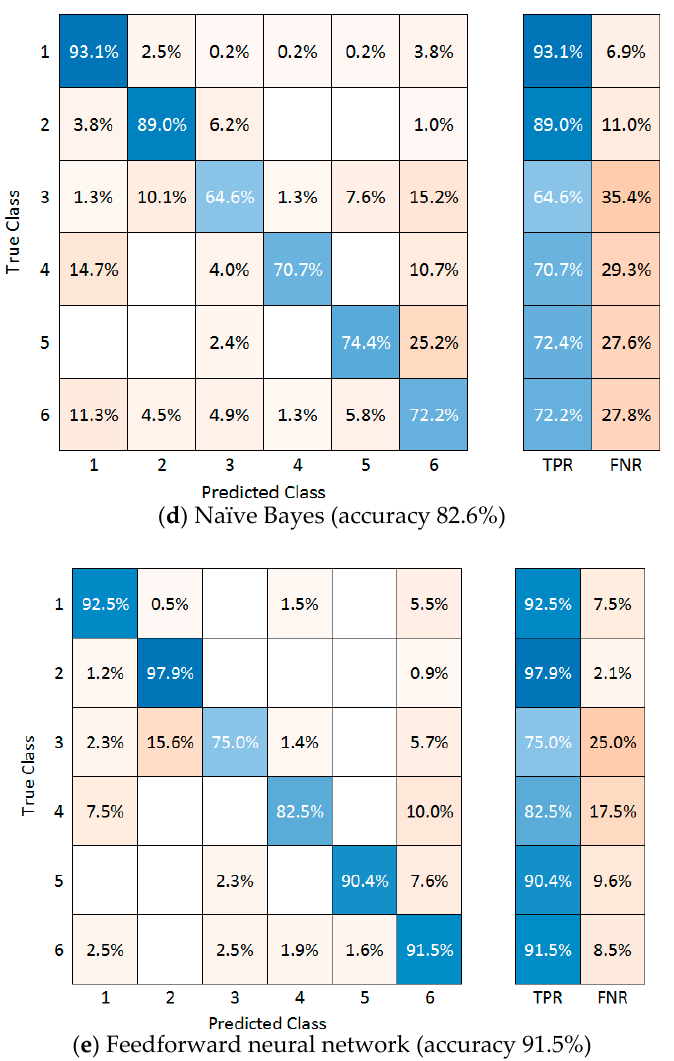
Figure 9. Experimental results with machine learning algorithms.